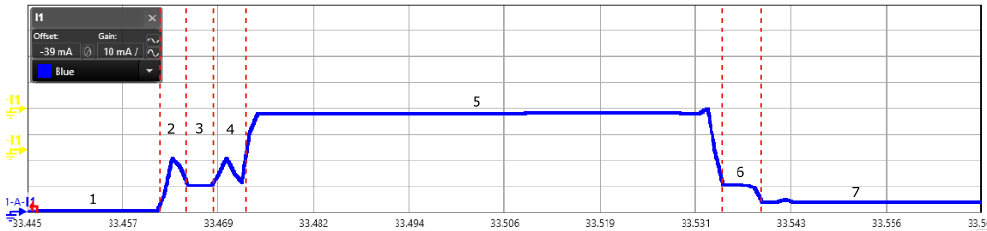
Figure 14. Scope view of a DASH7 data transmission in PULL mode captured using power analyzer for the measurement of energy